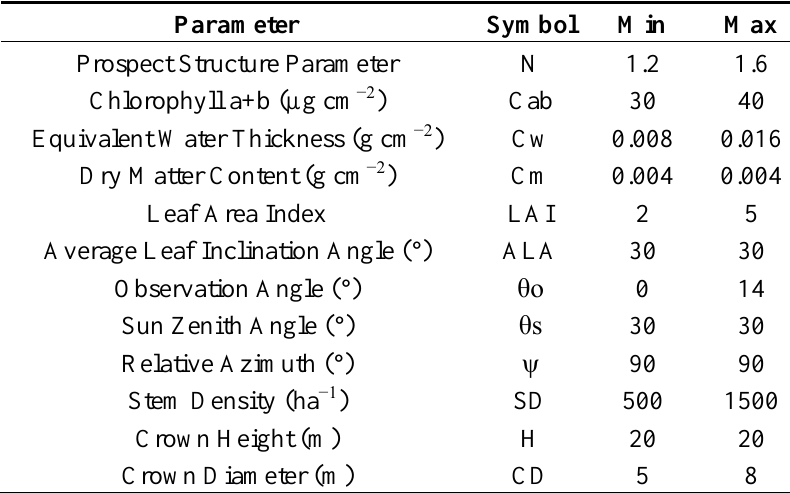
Table 2. Parameter ranges for